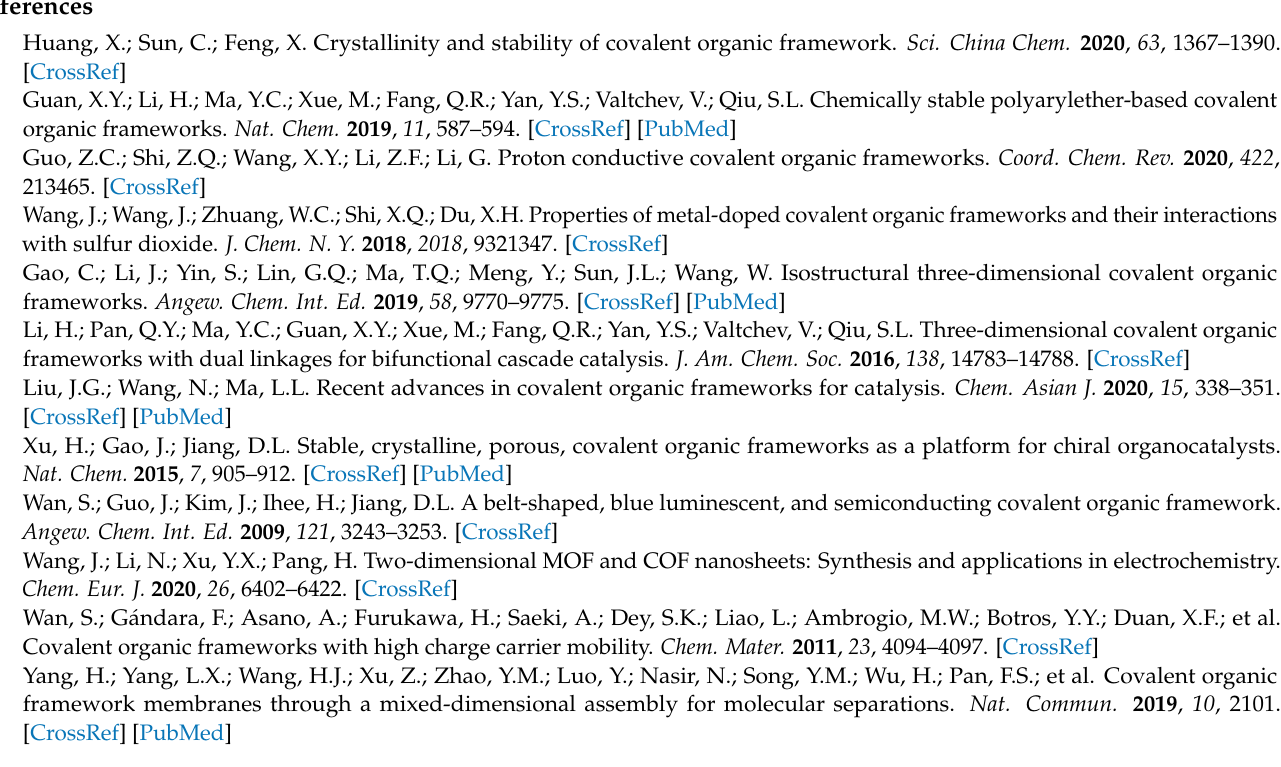
the film without CNCs. Figure S3: HR-TEM image of the flower center in COF-366 film with 100 µ L CNCs. Figure S4: AFM height image of COF-366 film with 100 µ L CNCs. Figure S5: XPS spectra of C1s. Figure S6: XPS spectra of